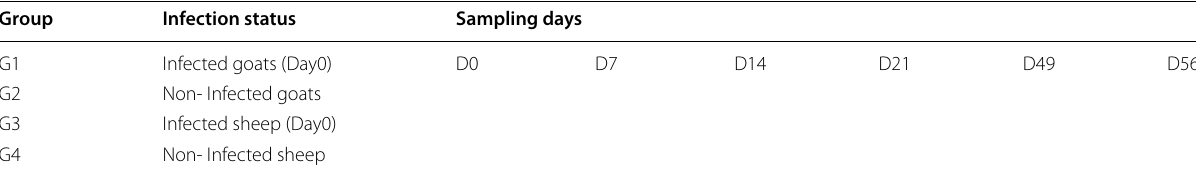
Table 1 Experimental groups and sampling